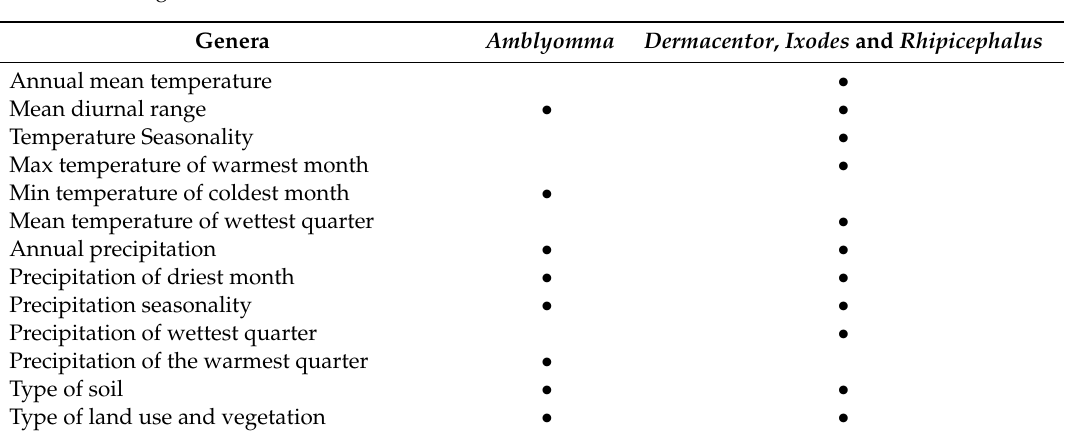
Table 1. Climatic and environmental variables used for the generation of ecological niche models of the four tick